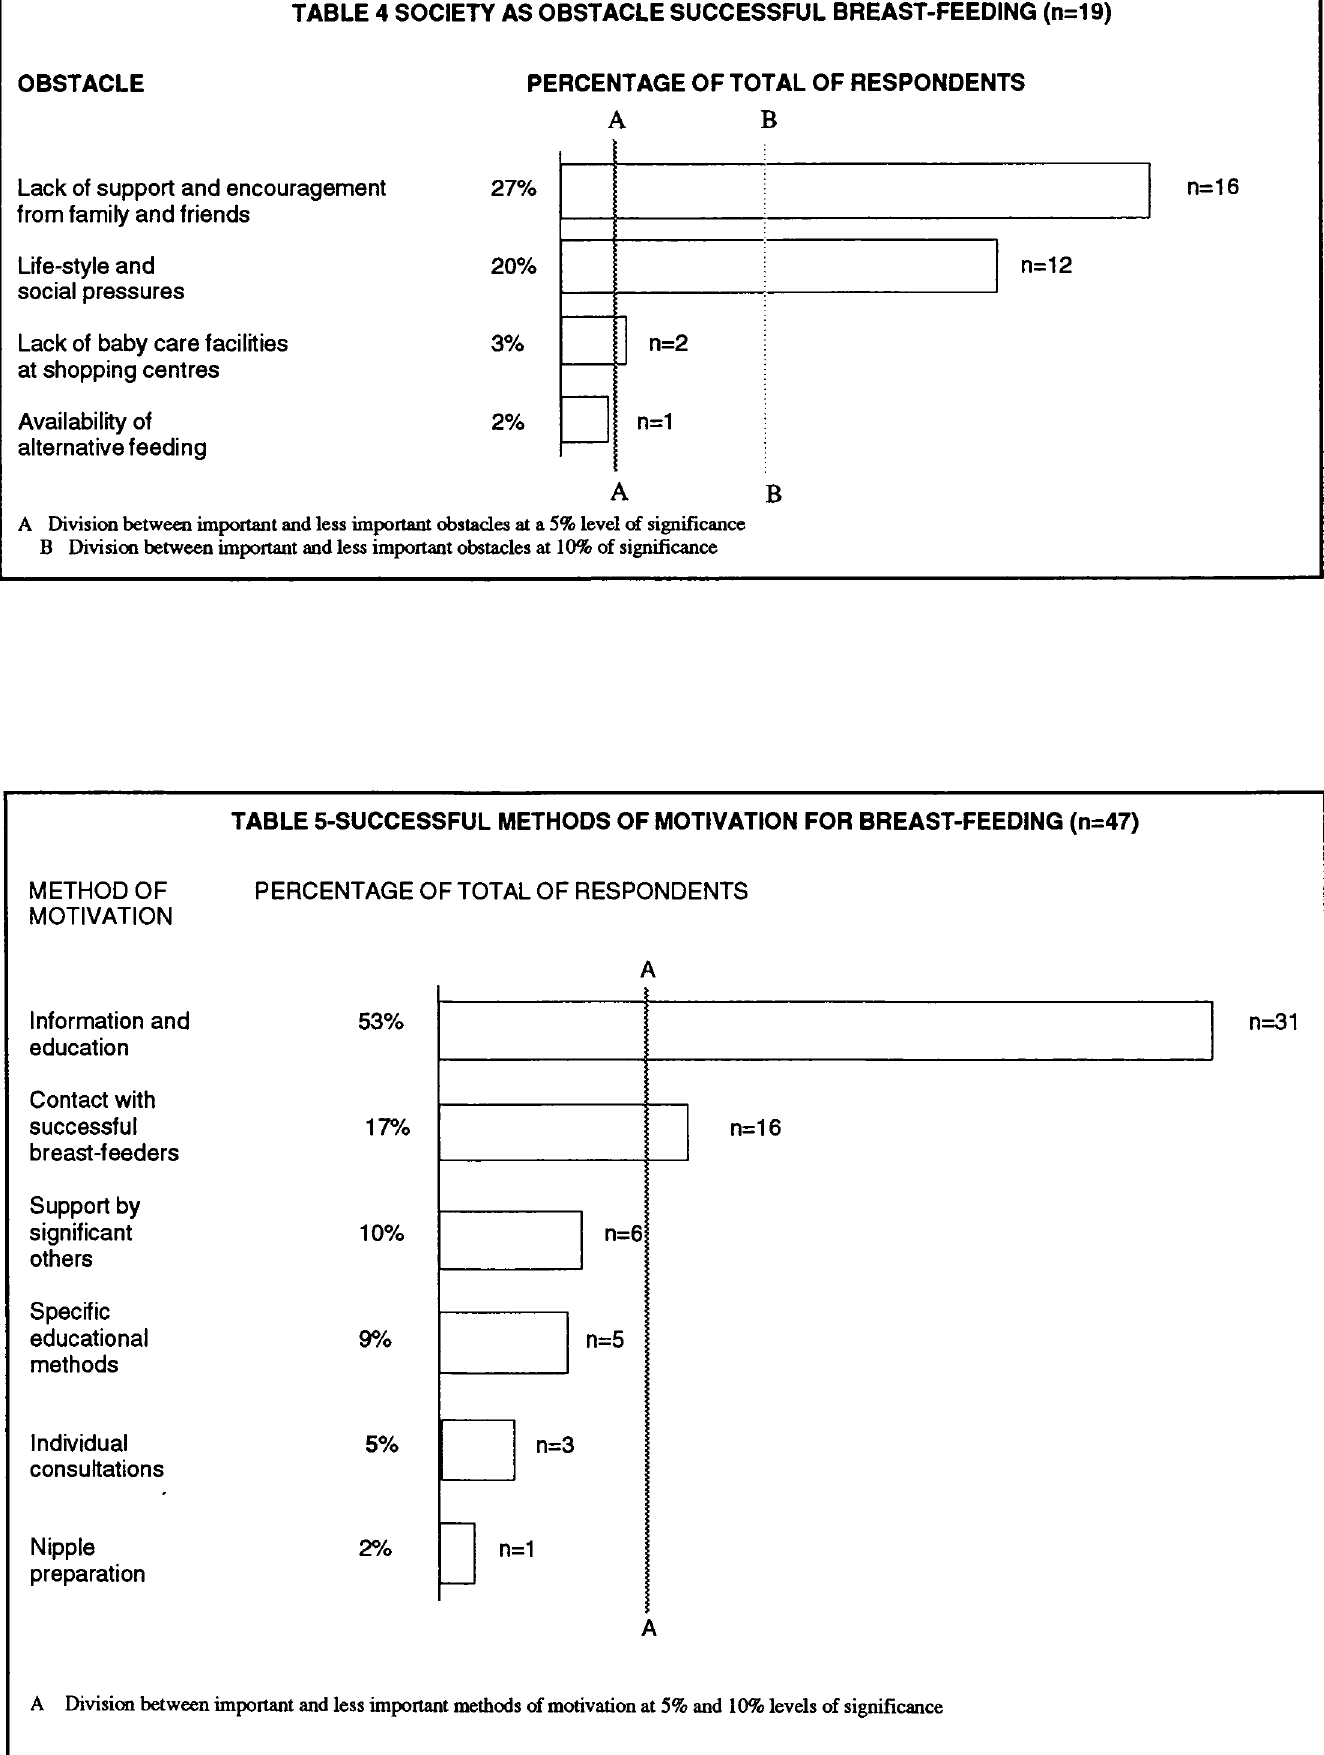
TABLE 4 SOCIETY AS OBSTACLE SUCCESSFUL BREAST-FEEDING (n=19) OBSTACLE